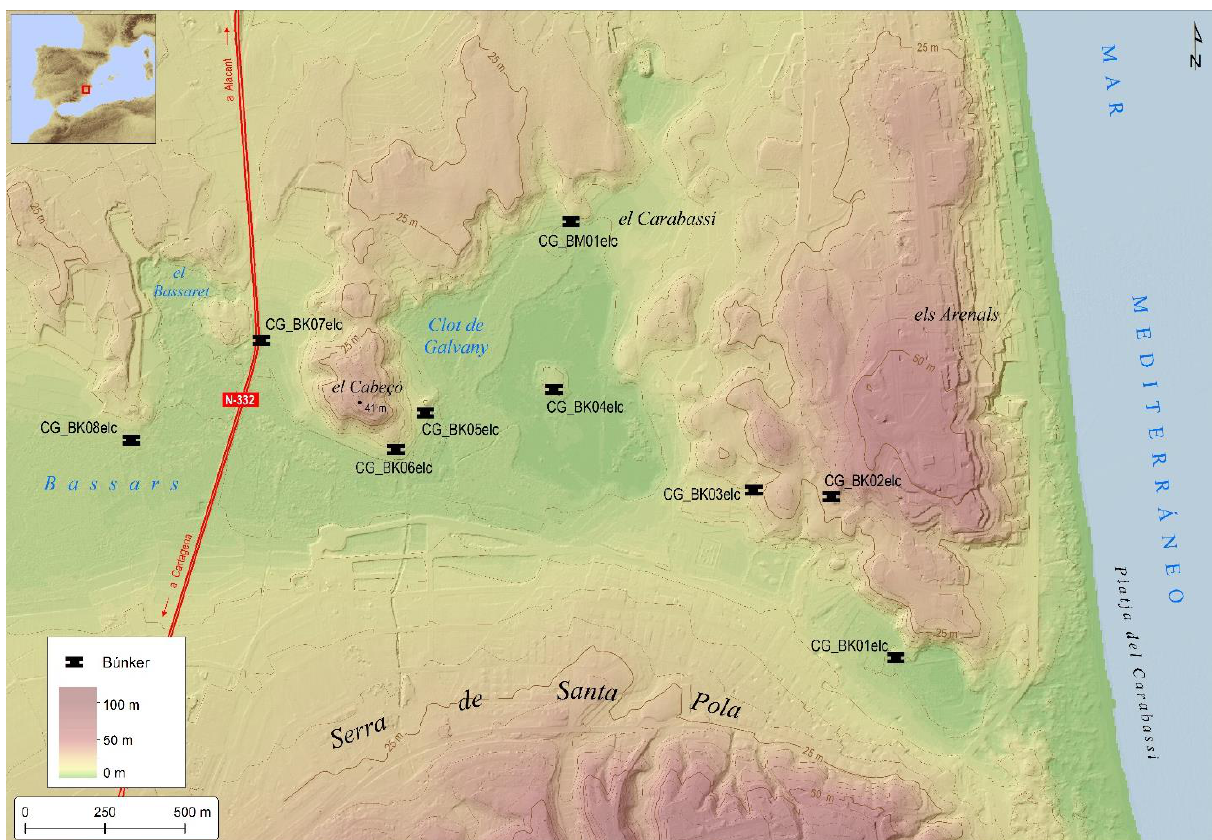
Figure 2. Map of the topography of the Clot de Galvany enclave where the 8 bunkers are located (the CG-BK04.elc is the largest and is located in the middle of the island of the lagoon). The Clot de Galvany is located in the lower part of the geography defined by the hills to the north (of lomas of Arenals and Cabeçó) and to the south (Santa Pola mountain range), connecting the beach of Carabassí with the National road N-332 (map: